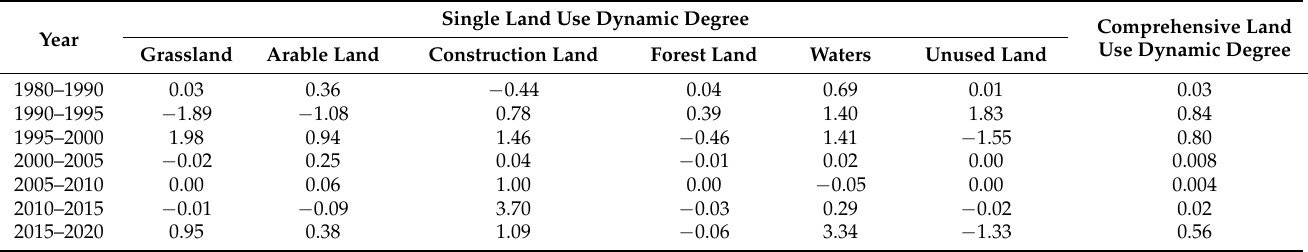
Table 4. Dynamic degrees of land-use types moving in the Qilian Mountains at different times